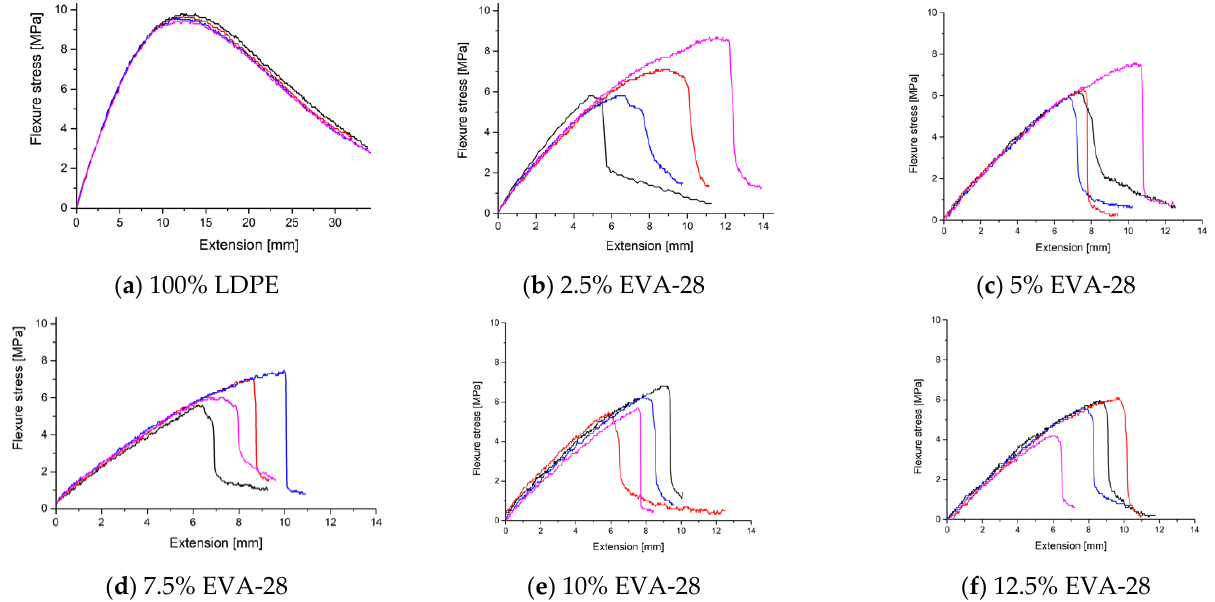
Figure 3. The flexural stress-strain curves of the LDPE/EVA mixtures.